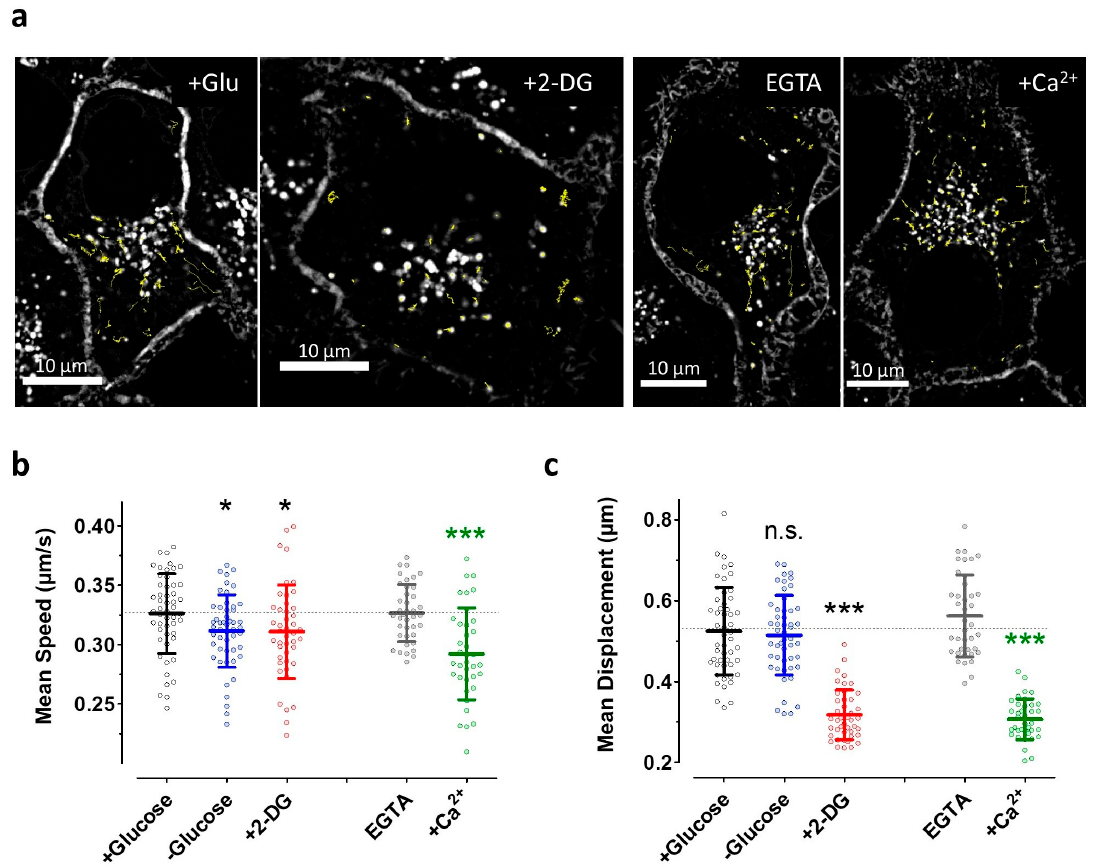
Figure 7. Vesicle motility in HeLa cells is di ff erentially a ff ected by Ca 2 + and energy stresses. ( a ) Confocal images of HeLa cells stably expressing pH-Lemon-GPI that were used for time-course vesicle movement experiments. The first images in the time courses of representative cells of di ff erent treatment conditions ( + Glu and + 2-DG, left panel; EGTA and + Ca 2 + , right panel) are shown. The tracks of all detected moving vesicles in 600 images over 2 min for each individual cell are shown in yellow. A 100 × magnification objective was used, scale bars represent 10 µ m; ( b , c ) Scatter dot plots and mean values ± SD representing mean speed (b) and mean displacement (c) for each cell measured at di ff erent (pre-)treatment conditions, i.e., + 10 mM glucose without any cell stimulation (control, black, n = 51 cells), − glucose (blue, n = 44), + 10 mM 2-DG ( + 2-DG, red, n = 50), cell treatment with 100 µ M ATP and 15 µ M BHQ in EGTA (grey, n = 39), or 2 mM extracellular Ca 2 + ( + Ca 2 + , green, n = 37). n.s. Not significant versus + glucose (control), * significant versus + glucose (control) p < 0.05, *** significant versus + glucose (control) p < 0.001, *** (green) significant versus EGTA p < 0.001, unpaired t -test.